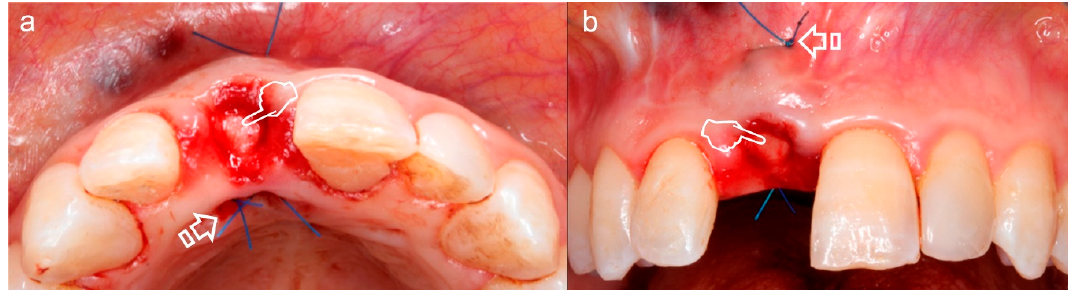
Figure 3. Subepithelial connective tissue graft for volume gain after immediate implant placement. The gain of the volume is better appreciated in ( a ) where an augmentation of the phenotype thickness is shown. A portion of the graft can be observed at the surgical area (pointers) ( a , b ). The sutures anchorage the graft (arrows) ( a , b ).